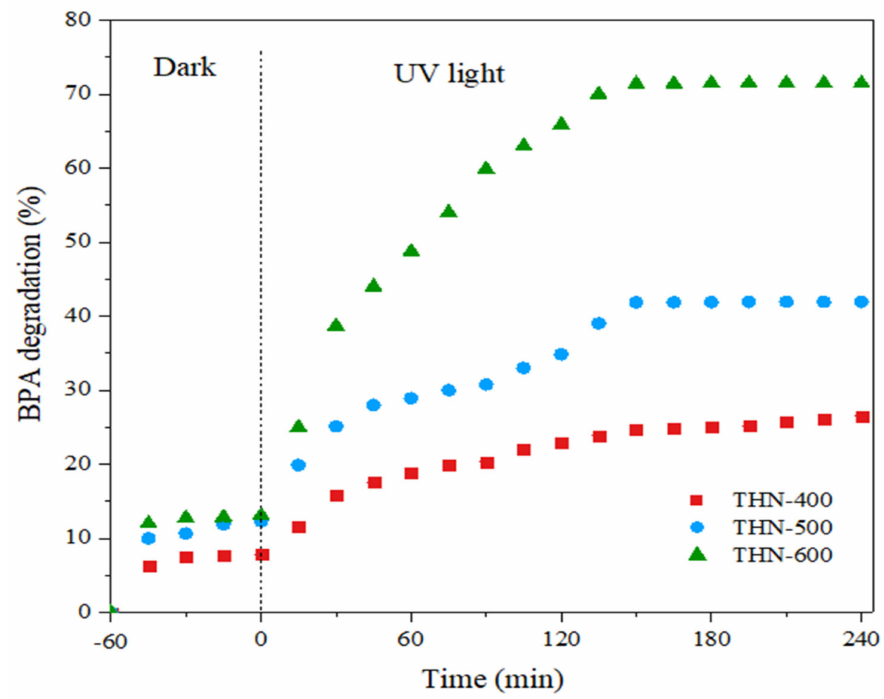
Figure 7. Degradation of BPA with different